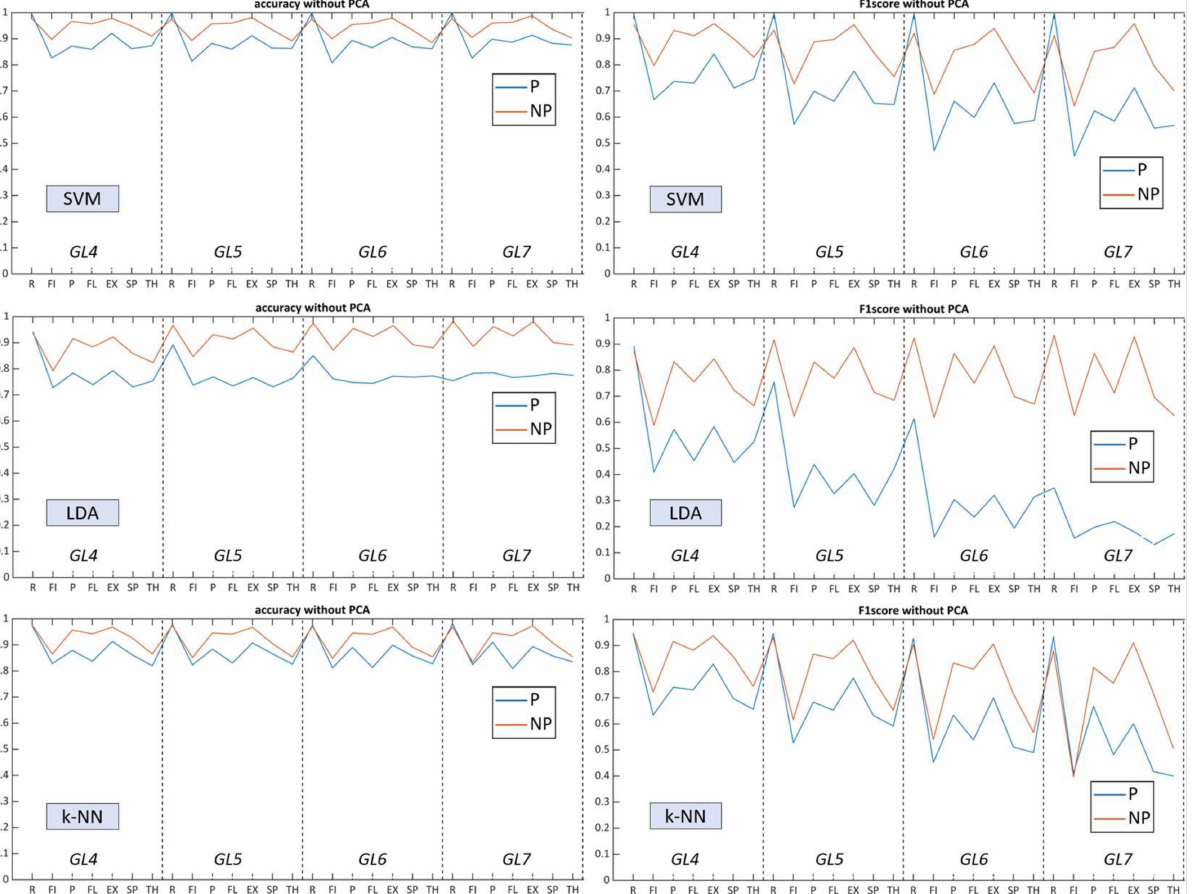
Figure 8. Total accuracy rate and F 1 -score from GL models on NP19 and P19 datasets without the PCA: top figures show mean Acc and F 1 from SVM, middle figures show mean Acc and F 1 from LDA, and bottom figures show mean Acc and F 1 from